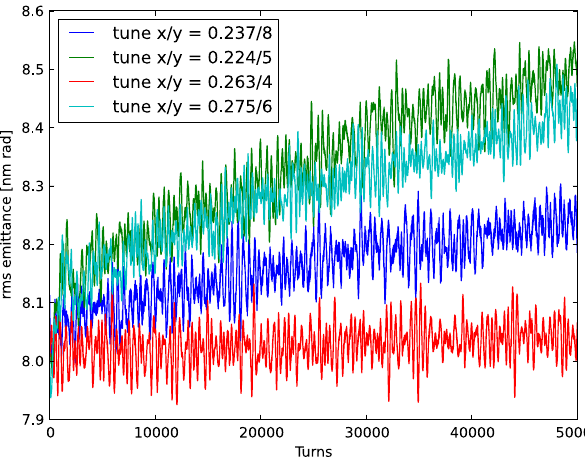
FIG. 8. Nonlinear 4D beam-beam simulation for different working points. The following parameters were used in calcu- lation: beam-beam parameter is 0.01; N 2 ¼ 180 ; m ¼ 161 , and n ¼ 19